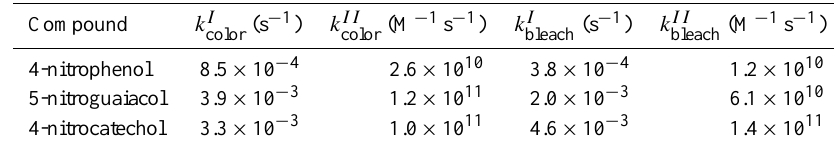
Table 3. Photo-enhancement and bleaching rate constants for nitrophenol OH oxidation determined from a simple kinetic model (Sect. 3.3.2). Note that the rate constants are absorbance-based and should be distinguished from concentration-based rate constants. Values reported here are the average of two replicates.